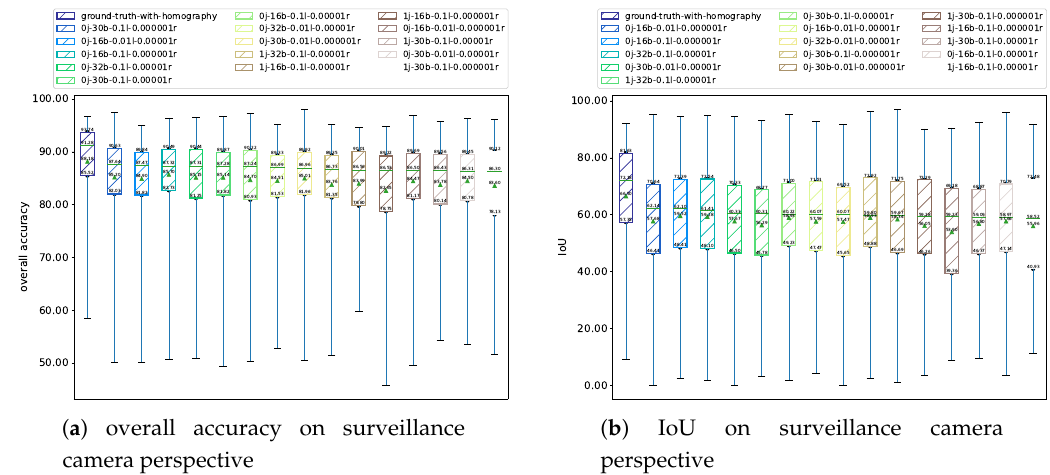
Figure 11. Segmentation camera results on the ITESM dataset (14 + 62 images): ( a ) is by using dlib’s measure—overall accuracy, ( b ) shows IoU. The bests model considering the medians (the mean is vulnerable to outliers) are for ( a ) 0j-30b-0.1l-0.000001r and for ( b ) 0j-16b-0.01l-0.000001r. Satellite ground truth homography transformation to the camera perspective is provided for reference. The experiments were named according to the following naming convention: <jittering was used> j - <batch size> b - <initial learning rate> l - <minimum learning rate> r